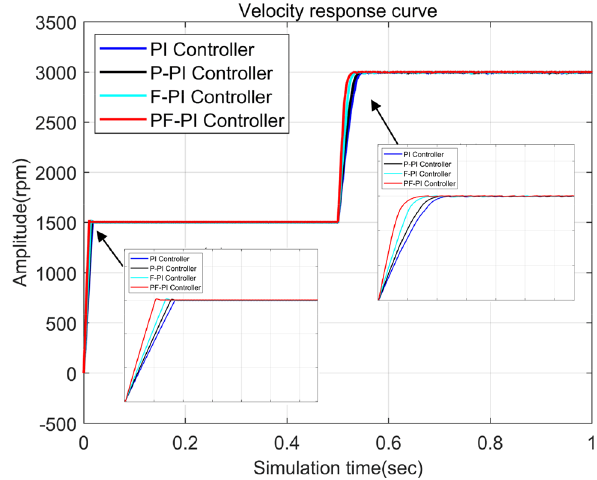
Fig. 13 Speed response curves of variable speed sudden addition disturbance load start under different conditions